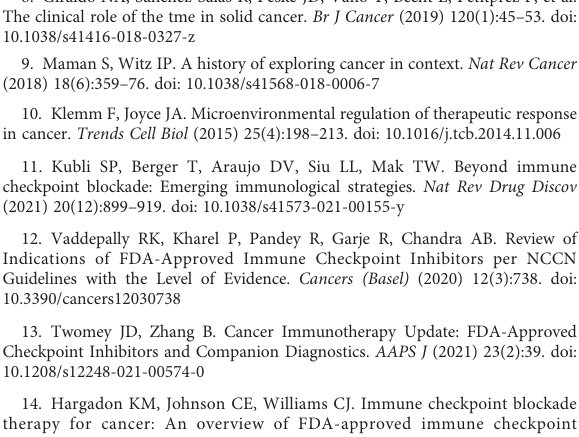
SUPPLEMENTARY FIGURE 1 Analysis of expression of SIGLEC15 . (A) pan-cancer mRNA expression of SIGLEC15 between tumor and normal tissues from PCAWG database. (B) mRNA expression of SIGLEC15 between paired tumor and normal tissues from THCA (Thyroid carcinoma). (C) Correlation between mRNA expression of SIGLEC15 and CD44 . SUPPLEMENTARY FIGURE 2 (A-K) Differential enrichment scores of immune signatures between high and low SIGLEC15 groups. (L) Enrichment scores of immune exhausted scores in low and high SIGLEC15 groups. SUPPLEMENTARY FIGURE 3 Single-cell analysis exploration of the expression cell type of SIGLEC15 . SUPPLEMENTARY FIGURE 4 Kaplan-Meier survival curves between SIGLEC15 expression and survival. SUPPLEMENTARY FIGURE 5 (A, B) Comparison of ampli fi cation and deletion of CNV in high and low SIGLEC15 mRNA expression groups. SUPPLEMENTARY TABLE 1 Correlation details in expression of SIGLEC15 and CD44